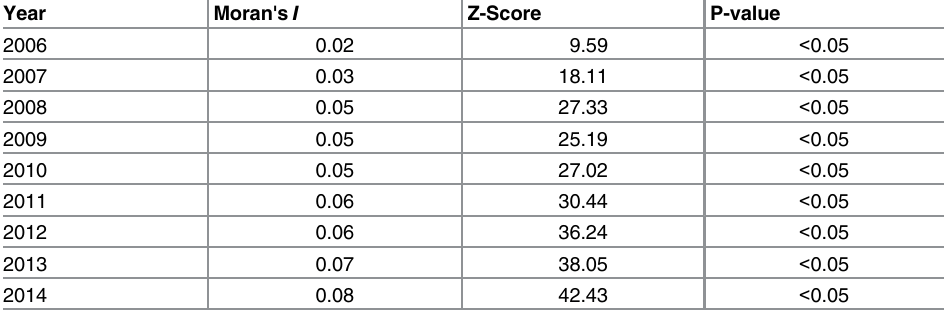
Table 1. Yearly spatiotemporal autocorrelation analysis on scrub typhus incidence in mainland China, 2006 – 2014.